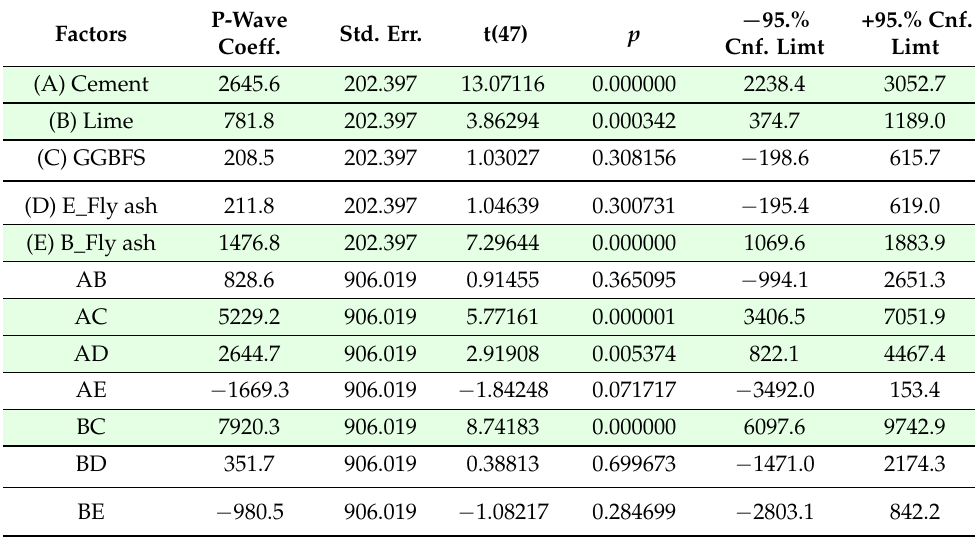
Table 3. The effects from various binders on soil stabilisation on day 14th of curing time, measured by P-wave